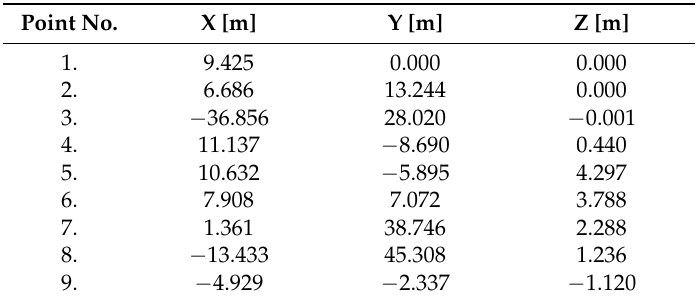
Table 2. Laboratory data set of points.